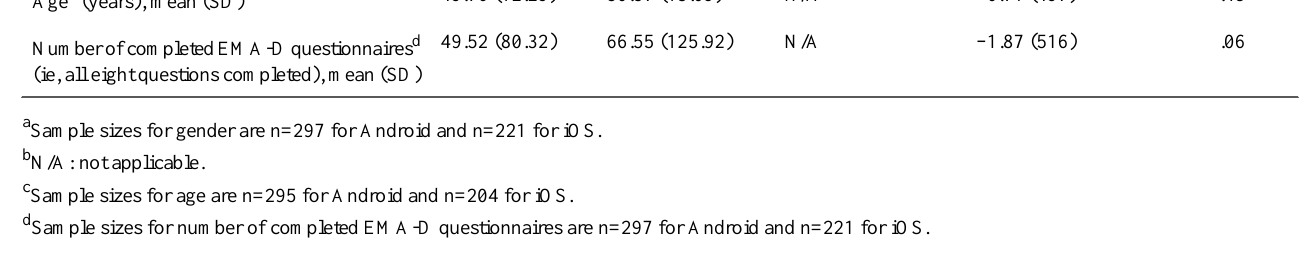
Figure 3. Frequencies of completed questionnaires of the investigated TrackYourTinnitus (TYT) users (n=518). EMA-D: dynamic ecological momentary